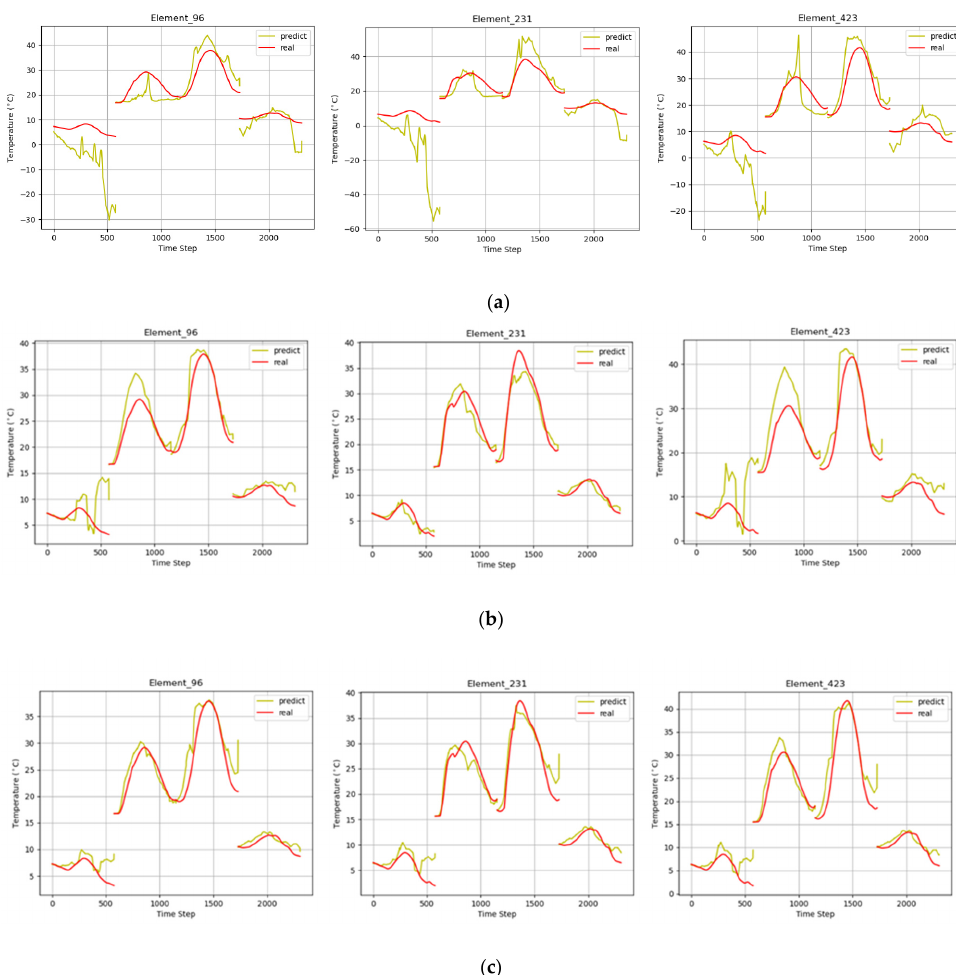
Figure 10. Generalization performance renderings. Prediction effect diagrams of ( a ) v-SVR; ( b ) CBPNN; and ( c ) MTPHNet.